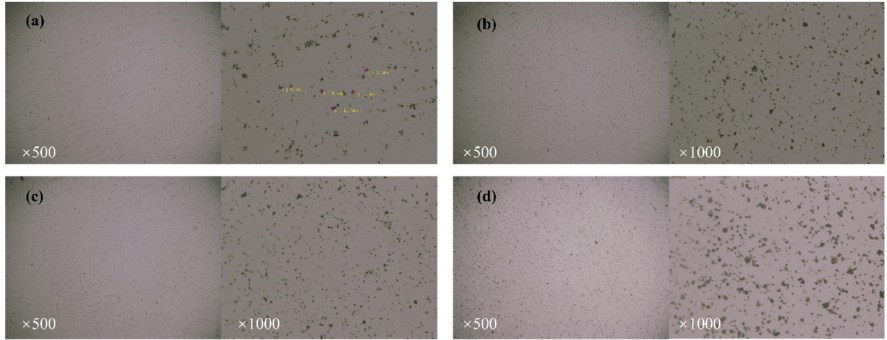
Figure 12. Ultra-depth field microscopy images of PSG in different systems: ( a ) PSG-W; ( b ) PSG-CHS; ( c ) PSG-CAS; and ( d )